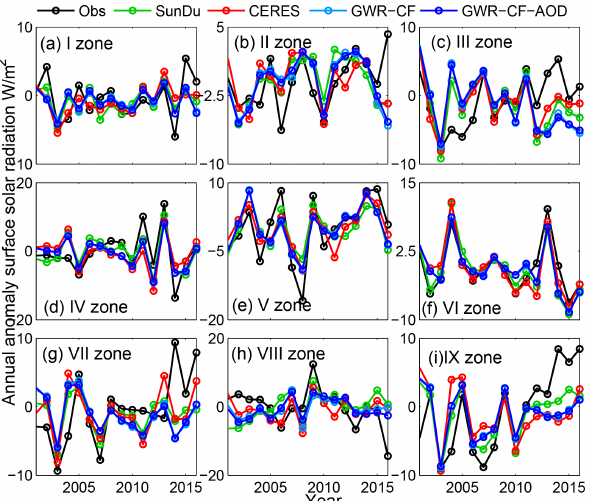
Figure 10. The regional mean of the annual anomaly of the surface solar radiation ( R s ) for different subregions. Nine subregions (I to IX) over China are shown in Fig. 1. Direct R s observations, SunDu- derived R s , and CERES EBAF are shown as black lines, green lines, and red lines, respectively. Light and dark blue represent the R s vari- ation derived from the GWR-CF and the GWR-CF-AOD